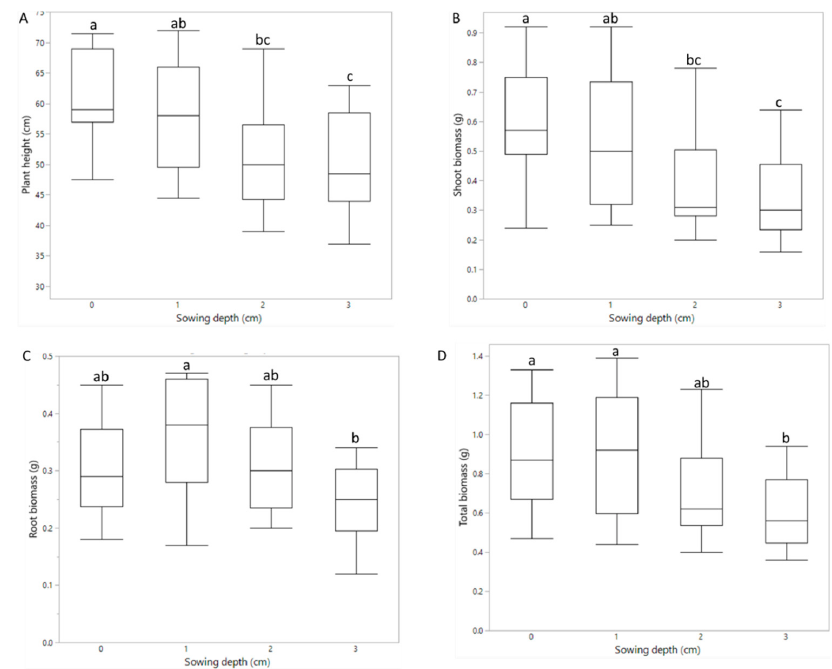
Figure 5. Pot experiment. Effects of sowing depth on ( A ) plant height, ( B ) shoot biomass, ( C ) root biomass, and ( D ) total biomass. Different letters indicate significant differences ( p < 0.05).